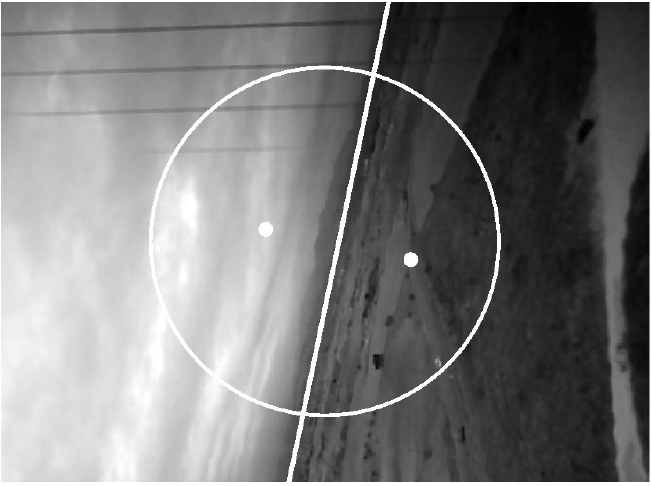
Figure 11. One of the frames processed by the vision system capturing the roll